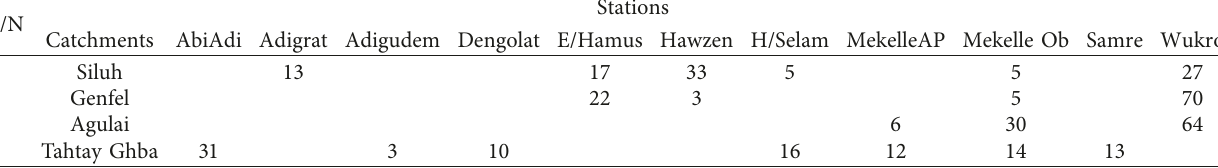
Table 1: Results of rainfall contribution of stations to each catchment by the Theisen polygon